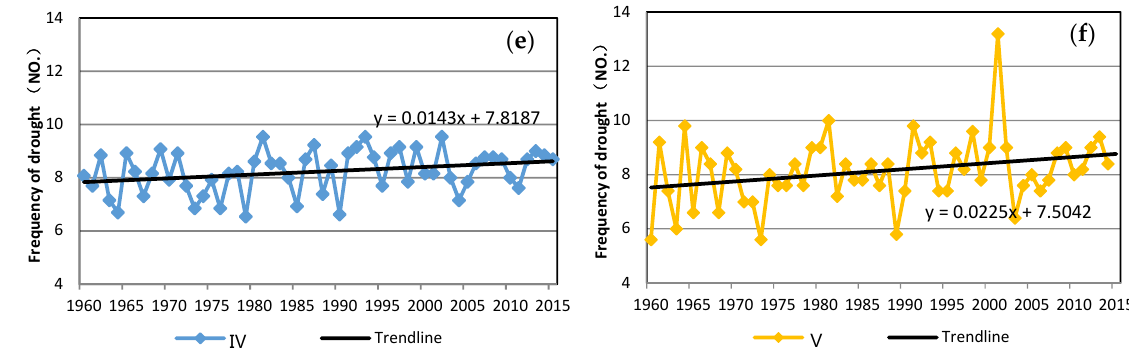
Figure 8. Trend analysis of drought frequency for ( a ) the Haihe River Basin and the five sub ‐ regions